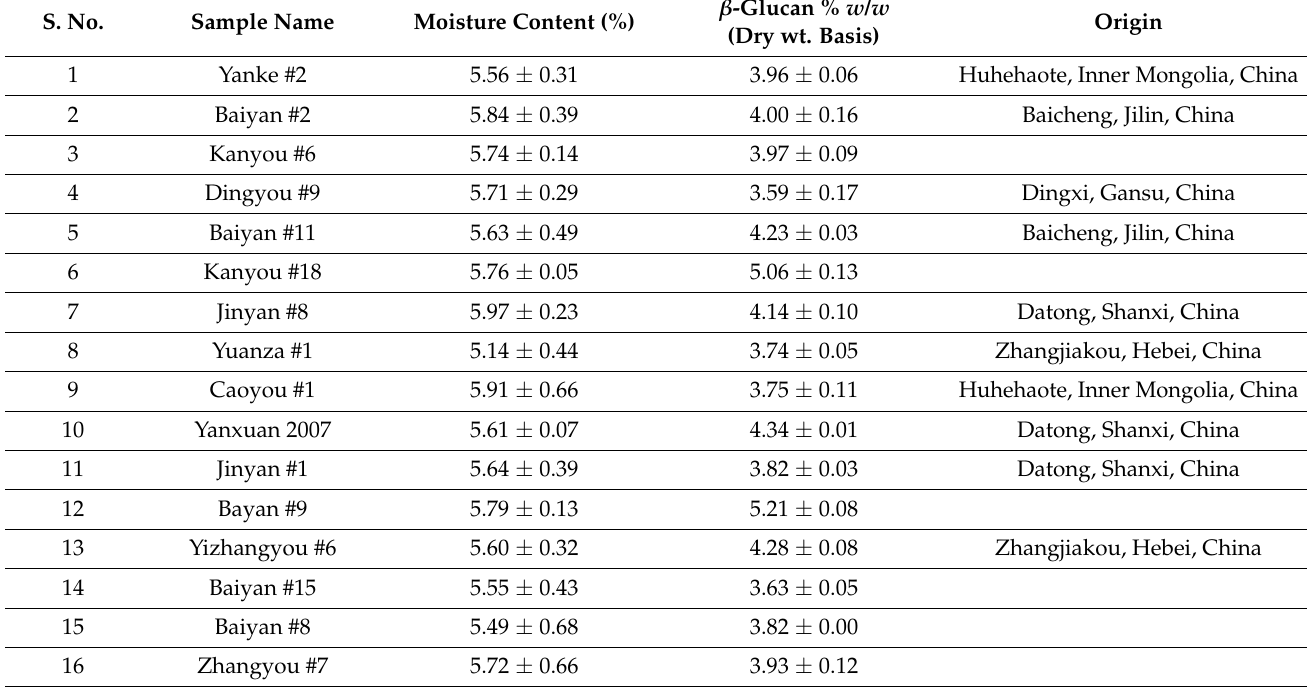
Table 2. β -glucan content, moisture content, and origin of naked oat